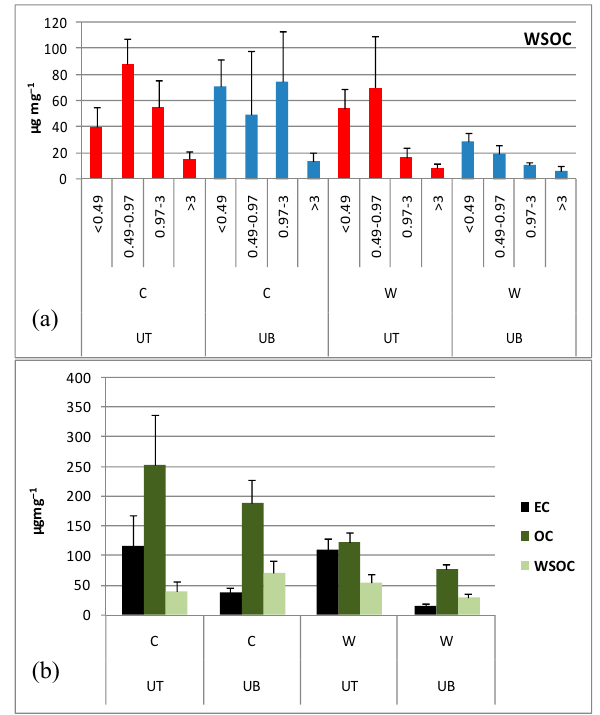
Figure 3. Mean ± SD of ( a ) the WSOC content in size-segregated PM, ( b ) the content of carbonaceous species in the <0.49 μ m particle fraction (UT: urban traffic site; UB: urban background site; C: cold period; W: warm period).